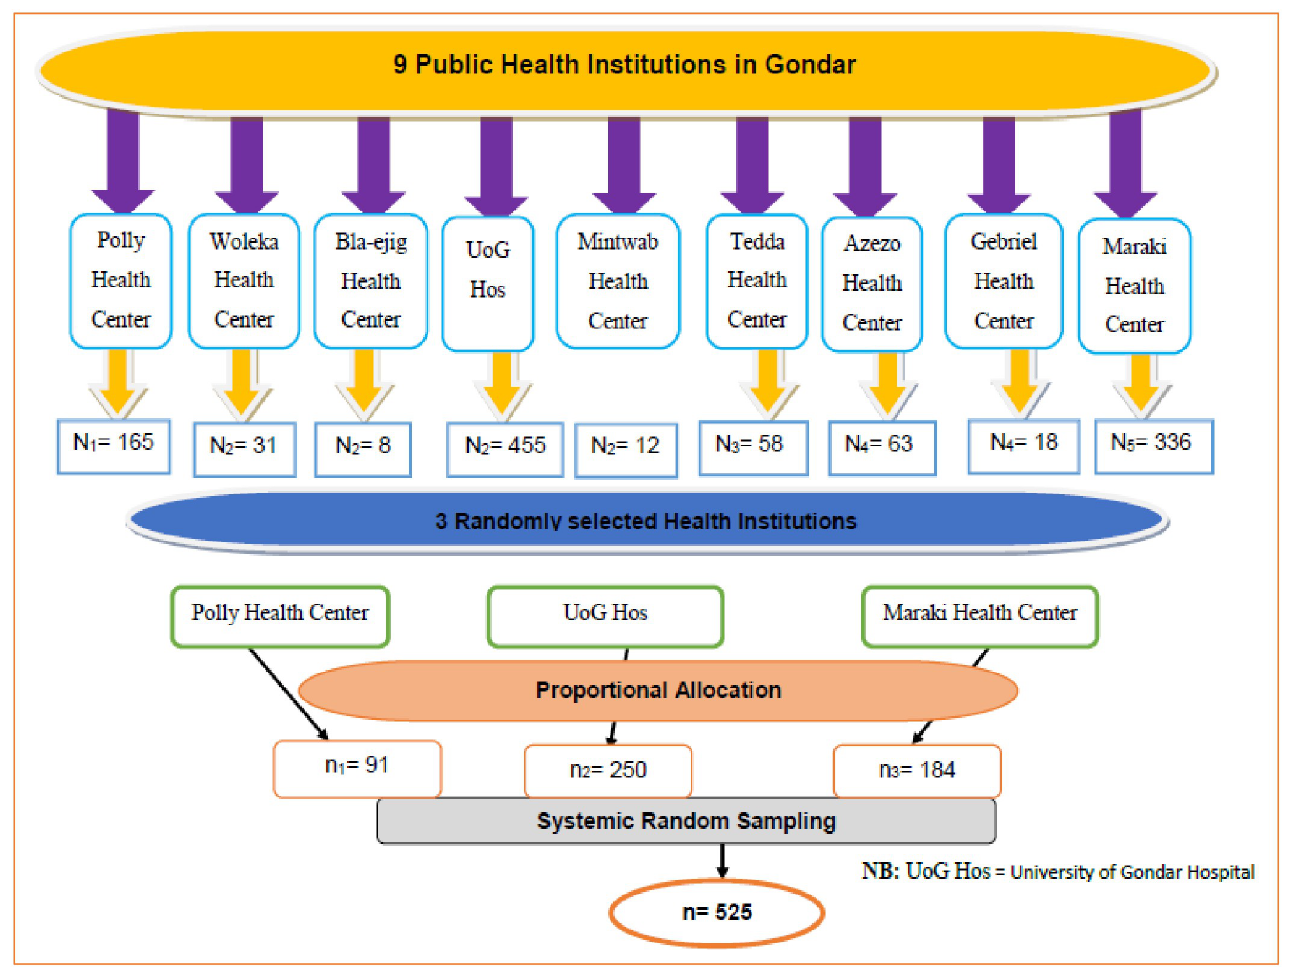
Fig 2. Schematic presentation of sampling procedure about COVID-19 vaccine acceptance and associated factors among pregnant women at Gondar town, Northwest Ethiopia, 2021.